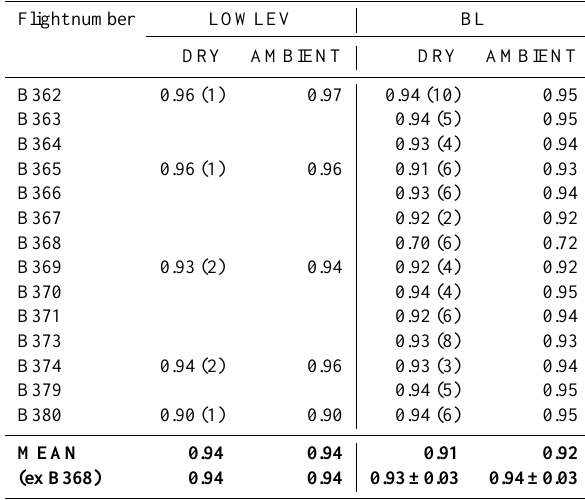
Table 3. Flight averaged SSA values for aerosol derived from PSAP and nephelometer for dry and ambient (scattering corrected for rel- ative humidity measured during run) aerosol. LOWLEV is mean of SLRs below 250m, BL is mean of all SLRs between 250m and 2000m, Numbers in brackets in the dry columns describe number of runs used to calculate the mean in each case. Where there is no entry in the table, no runs were made in that height region.